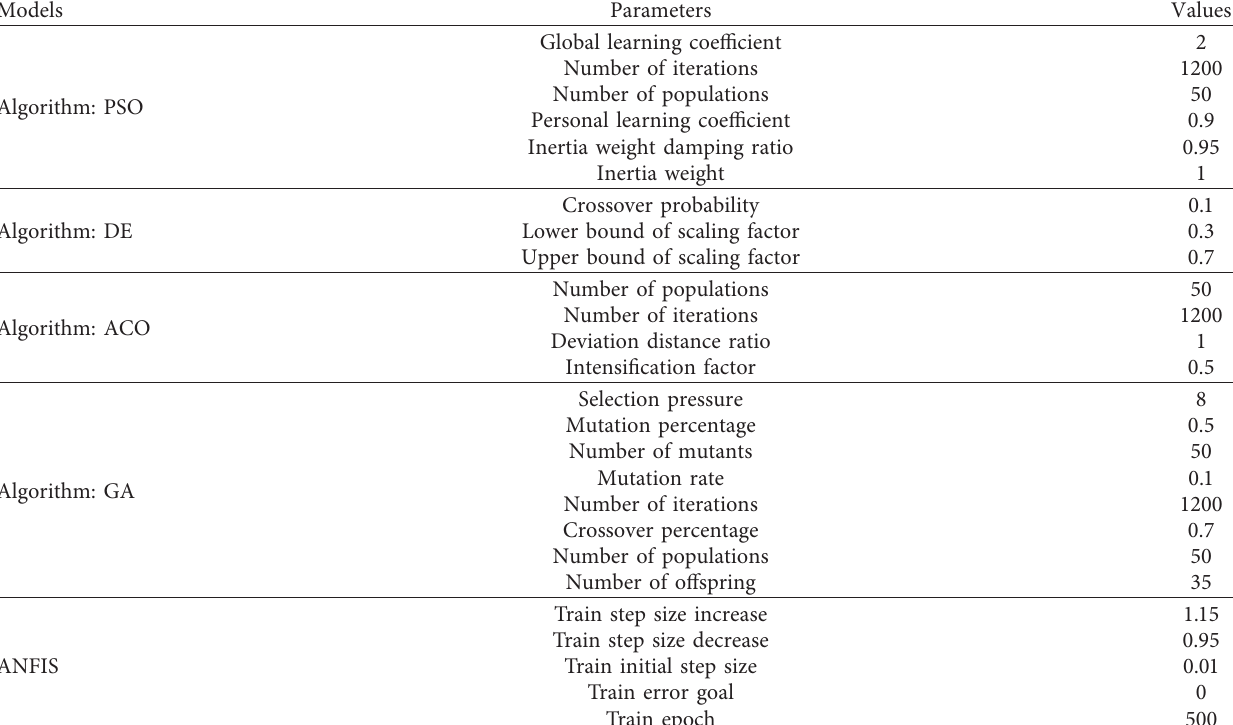
Table 1: The values of the models tuning